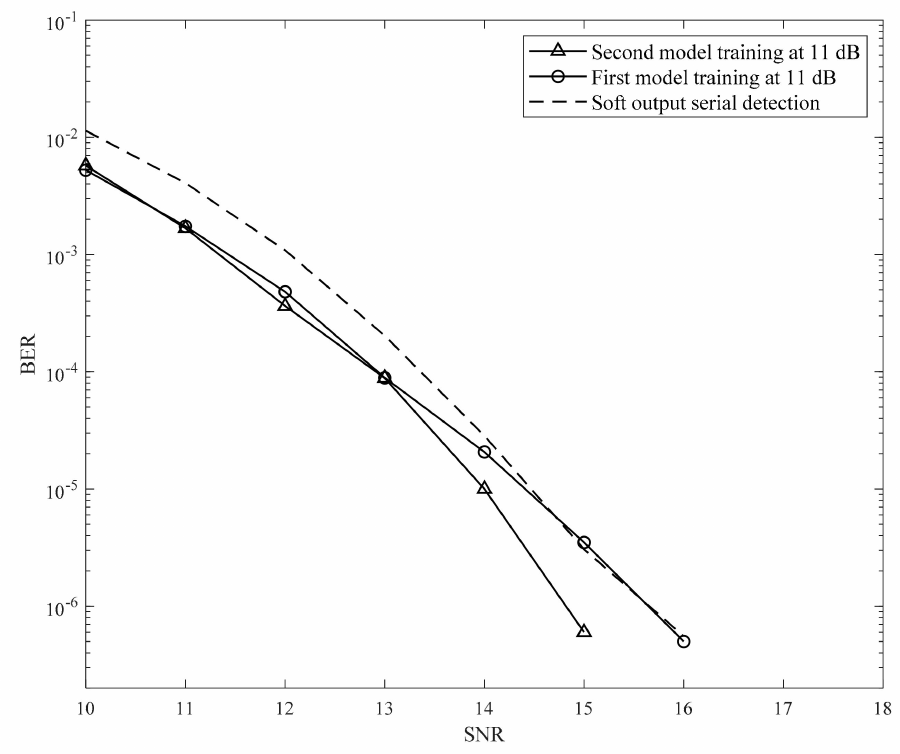
Figure 15. The BER performance of the second model.